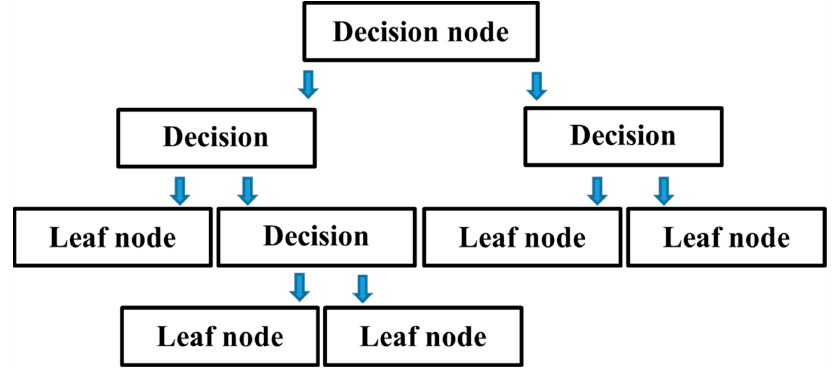
Figure 6. Flow chart of decision tree.